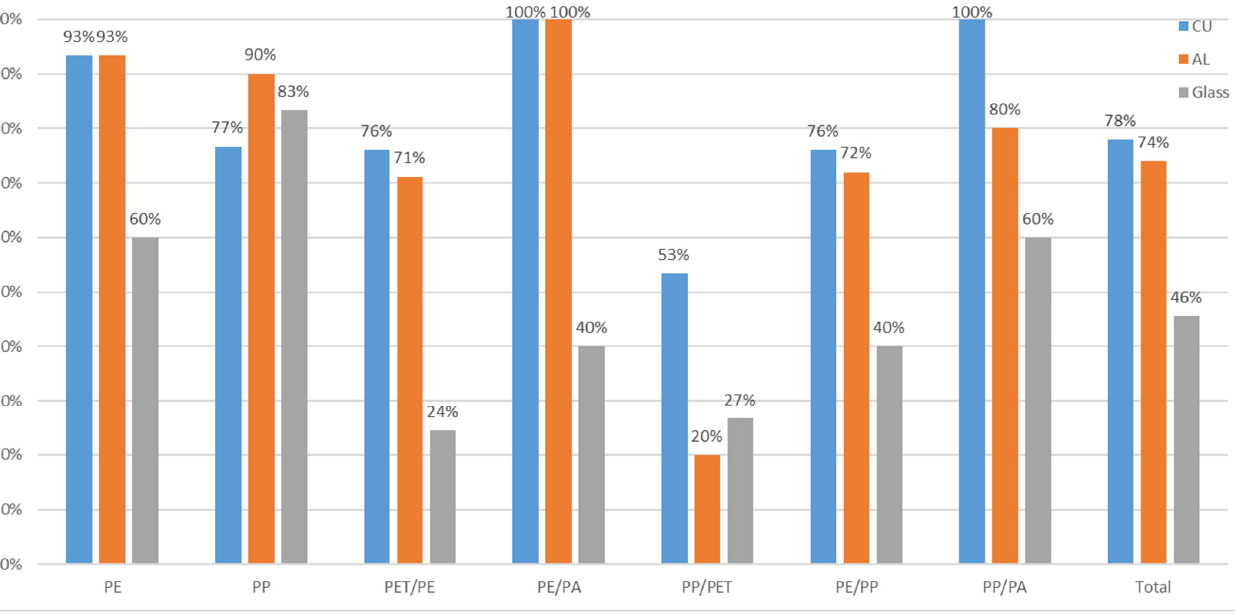
Figure 12. Detection rate with different reflectors concerning different materials.